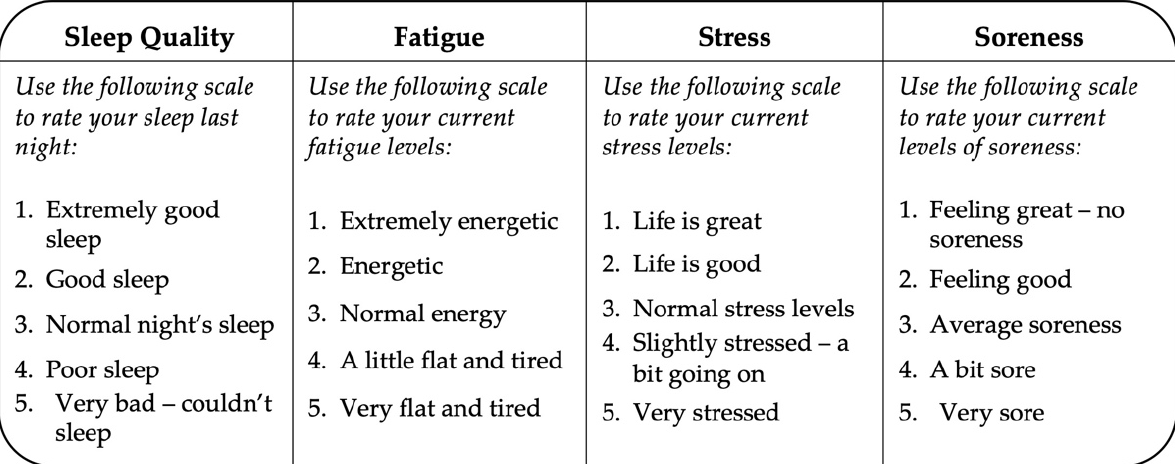
Table 1. Performance, fatigue and wellbeing outcomes in the follicular and luteal menstrual cycle phases.